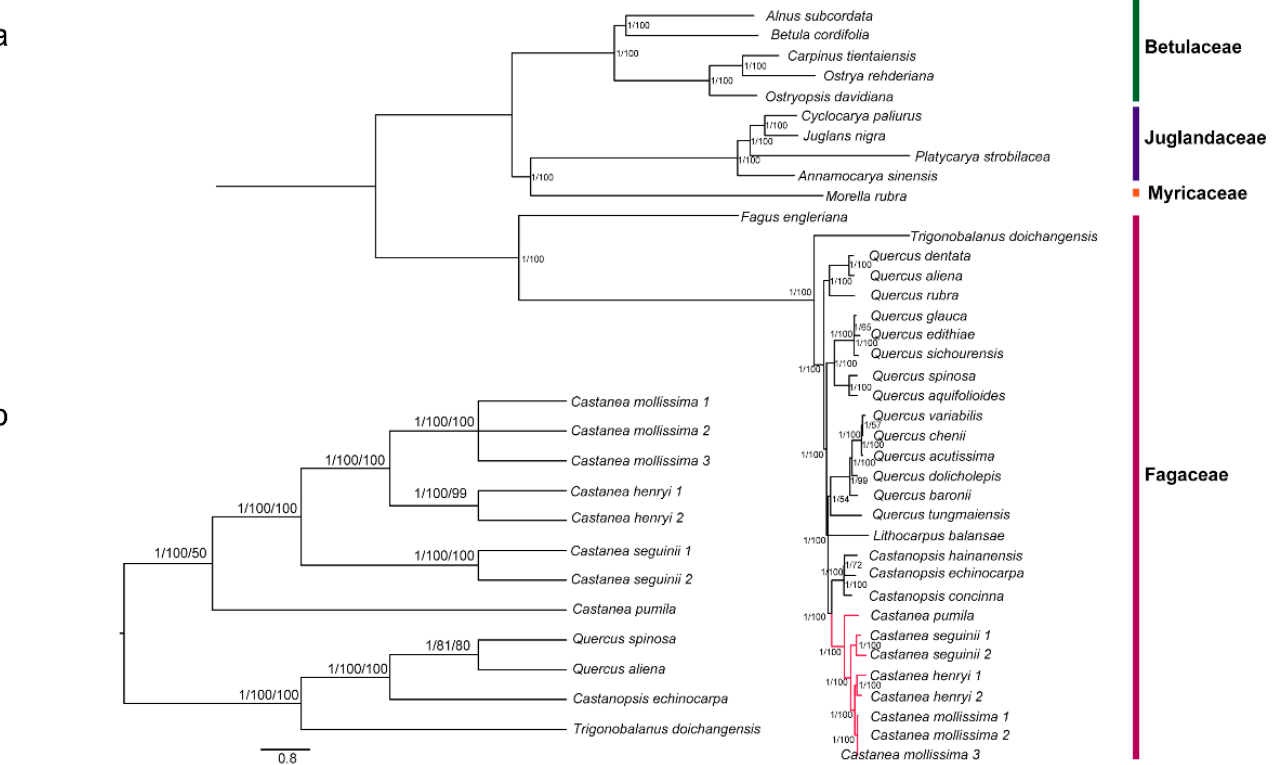
Figure 6. Phylogenetic trees (Maximum likelihood, Maximum Parsimony) based on whole-plastome sequences. ( a ) The phylogenetic tree based on 37 individuals using Bayesian (BI) and Maximum Likelihood (ML) methods. ( b ) Results of phylogenetic analysis of sequence data from the chloroplasts of eight Castanea individuals and four outgroups using Bayesian (BI), Maximum Likelihood (ML), and Maximum Parsimony (MP), methods. Bootstrap values (%) are shown above branches based on two and three methods.